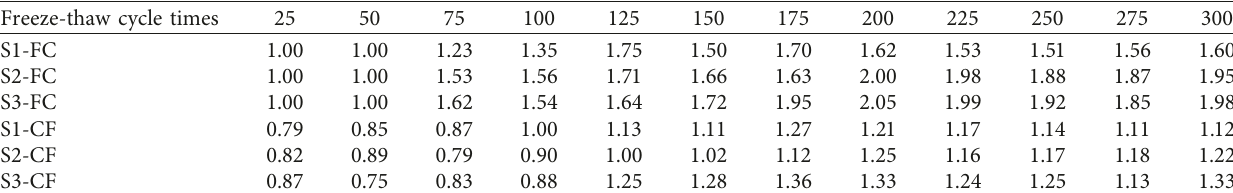
Table 6: Calculation results of the influence coefficient ( λ